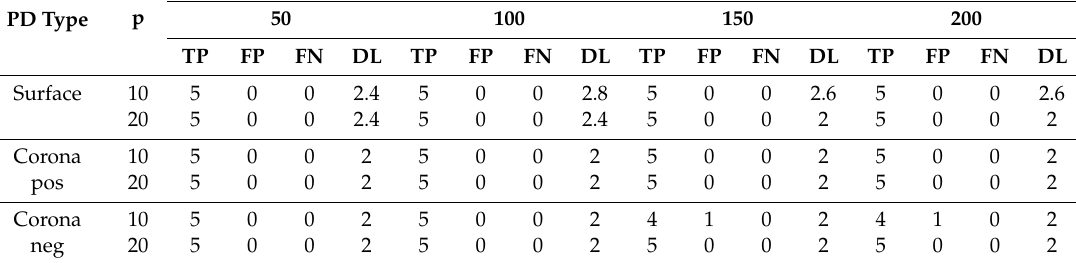
Table 3. PD detection performance for surface and corona types. The number of phase windows accumulated in a single cycle, q, and the number of forward-moving phase windows, r, were fixed as 360 and